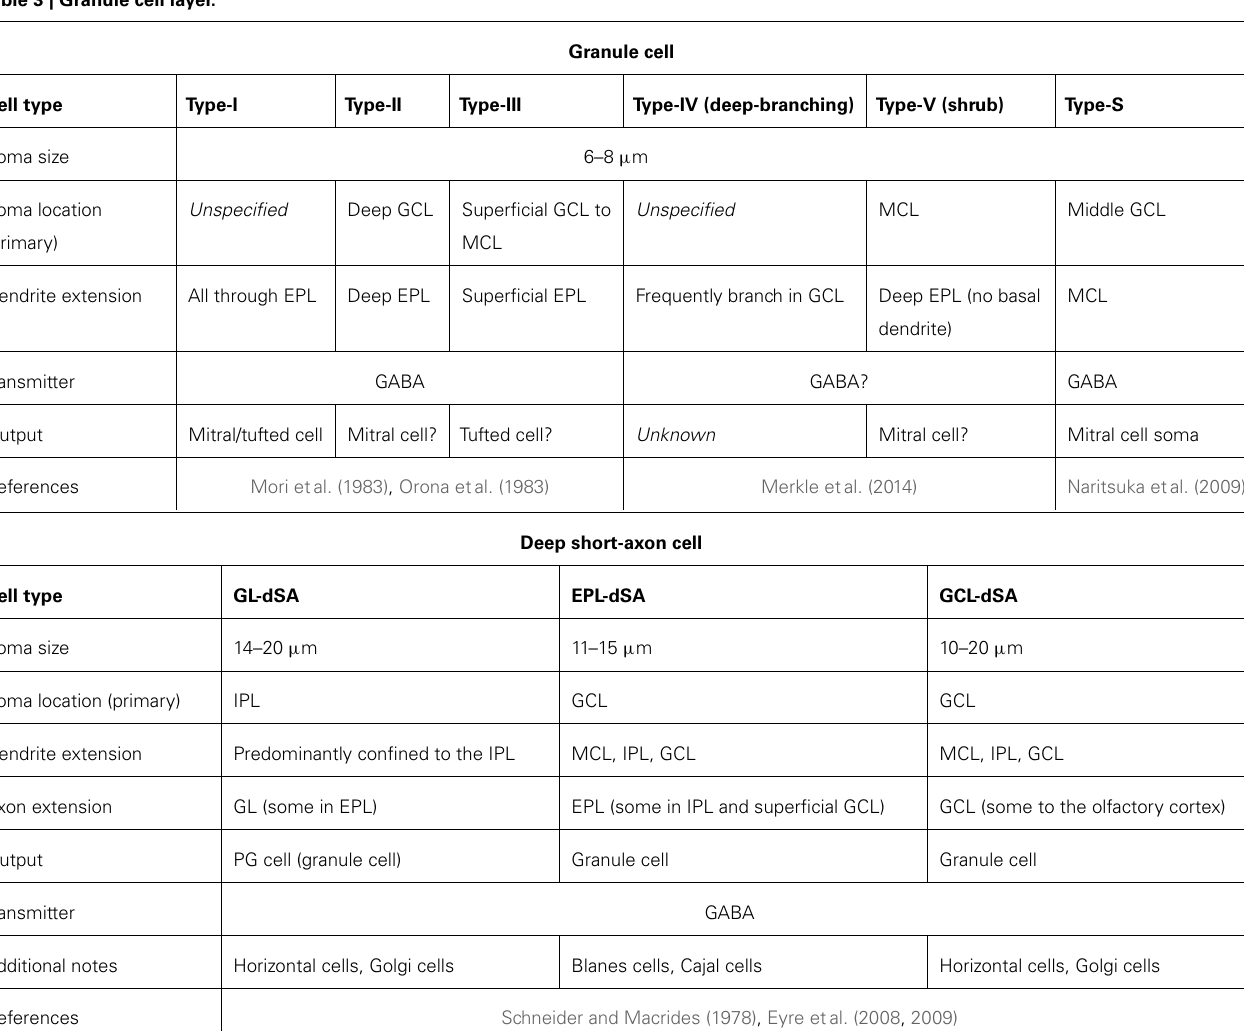
Table 3 | Granule cell